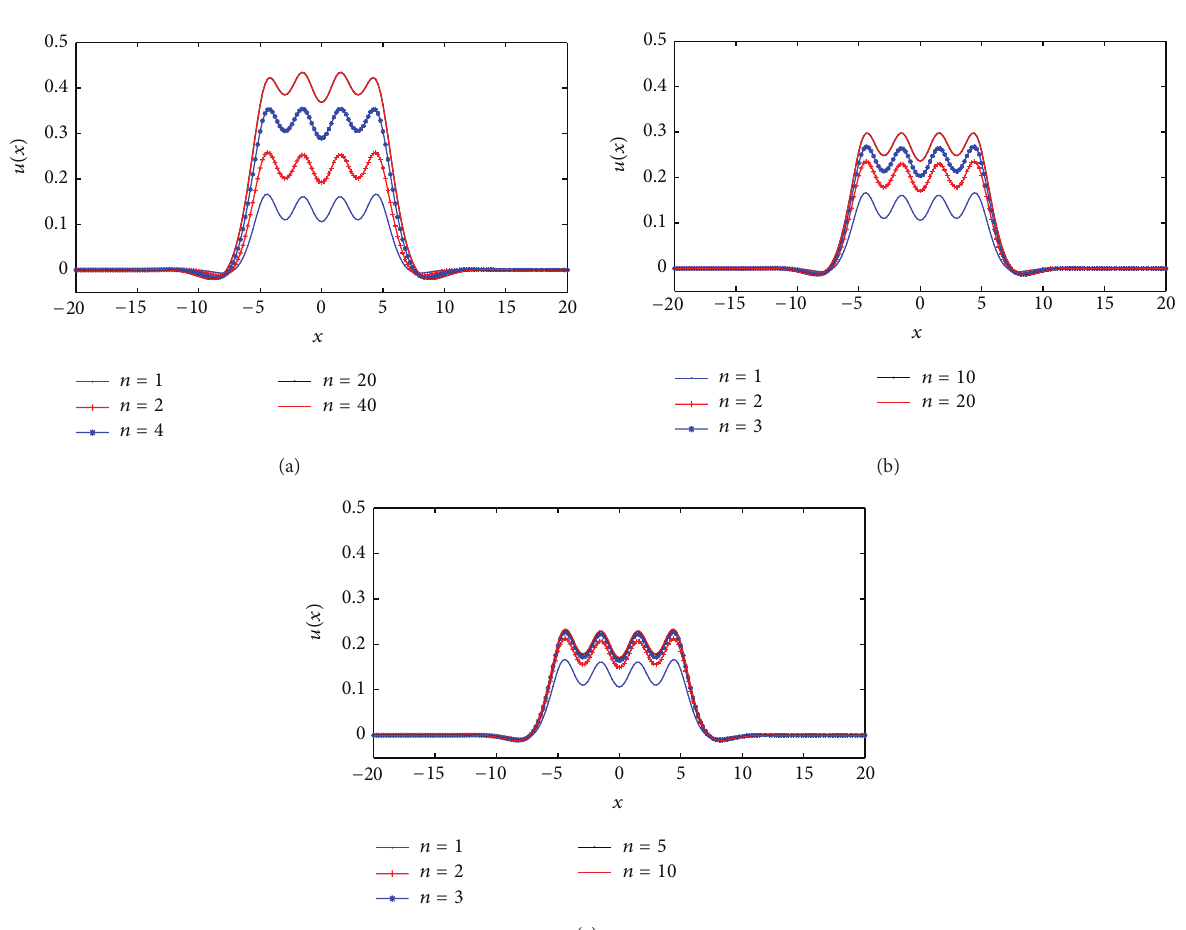
Figure 12: Convergence behavior of the solutions 𝐸 = 𝐼 = 1 , 𝛾 = 0.2 , and 𝑘 𝑝 = 3 : (a) 𝑘 = 1 , (b) 𝑘 = 1.5 , and (c) 𝑘 = 2